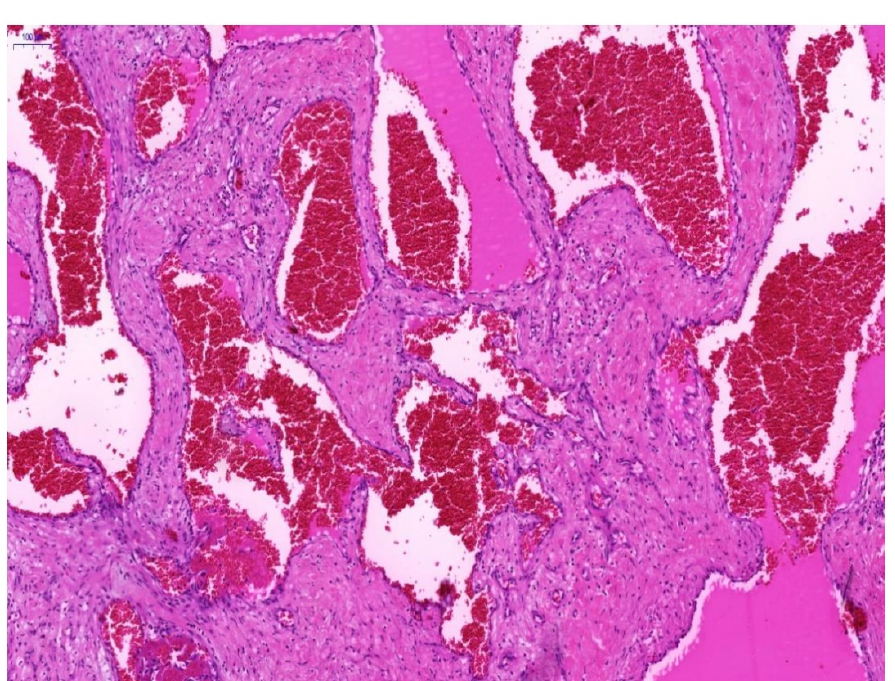
Figure 1. Photomicrograph of a specimen of orbital cavernous hemangioma. Hematoxylin-Eosin staining showed a dilated vascular cavity lined with flattened endothelium and a thick vascular wall. Representative image is presented (magnification ×300. Scale bar 100 μ m).